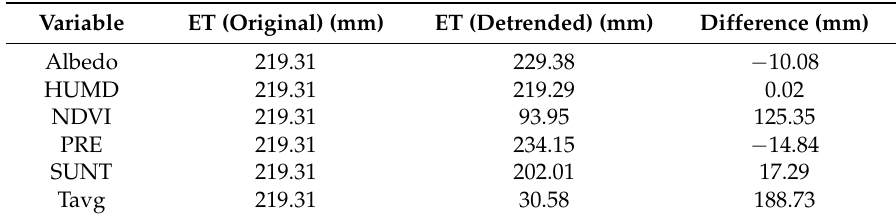
Table 3. The difference between original ET and recalculated ET based on detrended parameters series from the 1st to 191st day of 2014 in the Hai Basin,